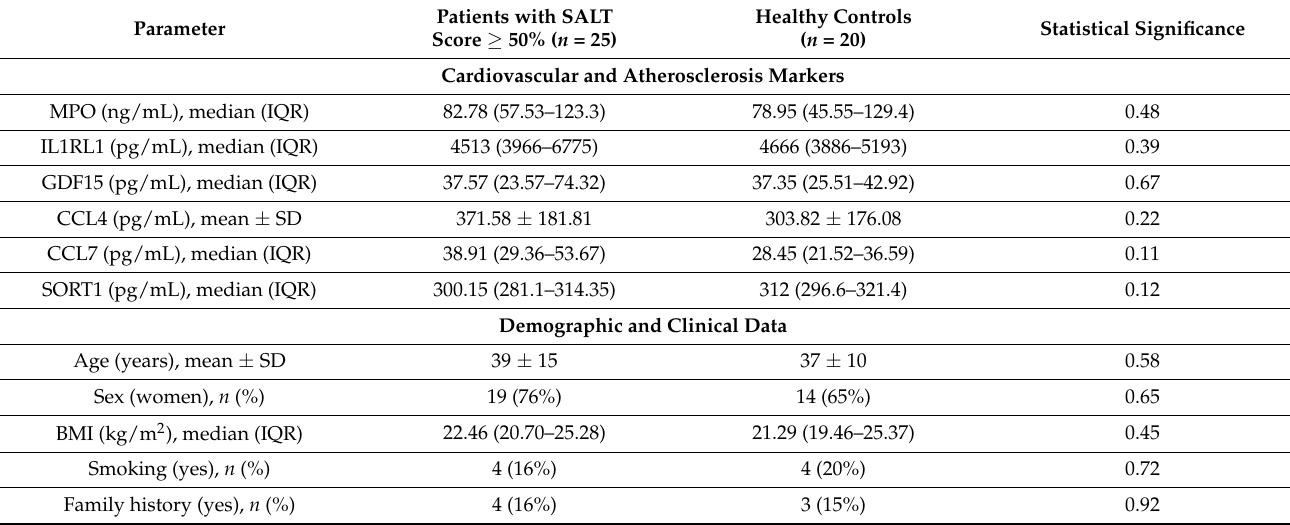
Table 4. Baseline characteristics and assessment of cardiovascular and atherosclerosis markers in patients with a SALT score ≥ 50% compared to the healthy